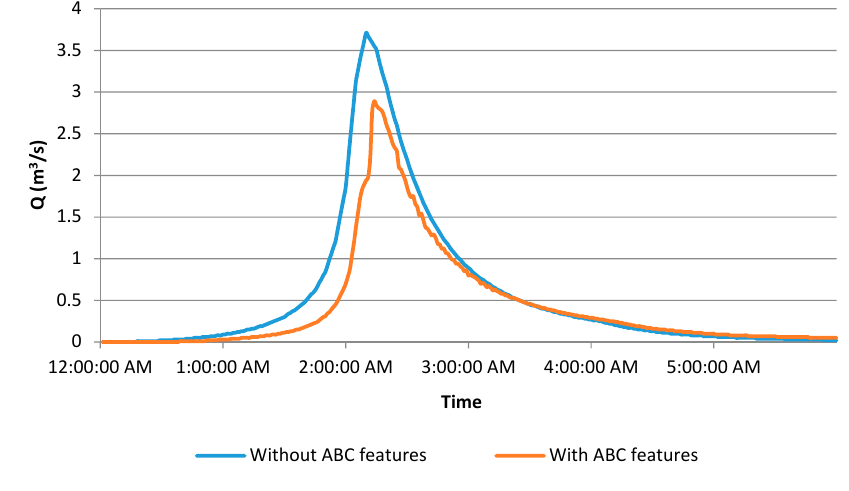
Figure 13. Discharge at Sungei Api Api outfall.